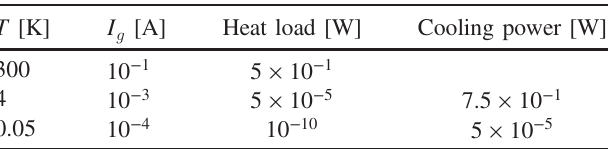
TABLE I. Power budget for an active circulator with control lines thermalized to T ≈ 7 K as described in the text. In this configuration, the circulator adds 0.3 photons of noise. A contact resistance of 10 milliohms is assumed at the chip interface. Cited cooling powers are for an Oxford cryogen-free dilution refrig- erator and are